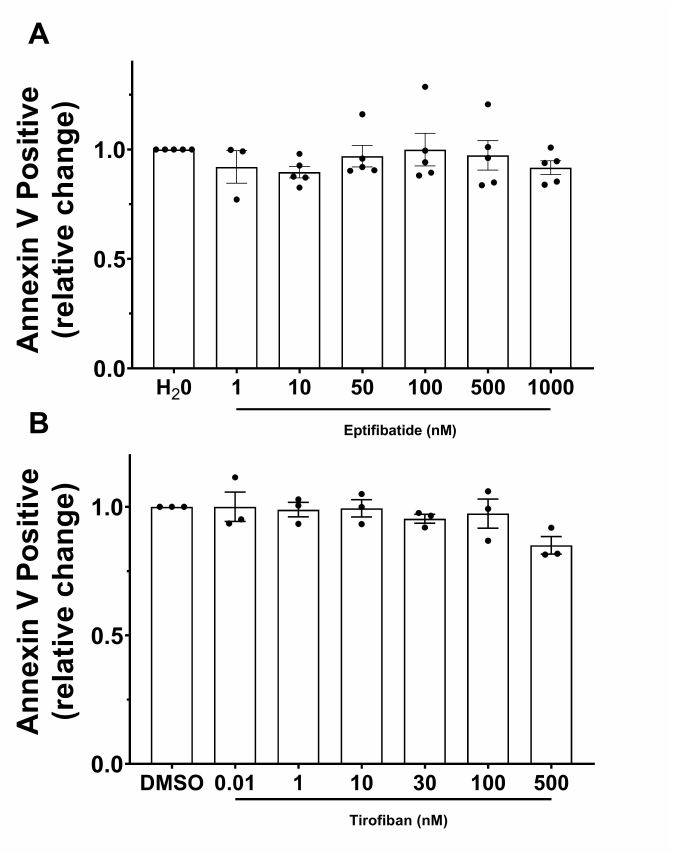
Figure 4. GPIIb / IIIa-antagonists e ff ect on the formation of procoagulant COAT platelets. Platelets were pretreated with increasing doses of ( A ) eptifibatide or ( B ) tirofiban, and activated with convulxin-plus-thrombin. Relative change of the fraction of Annexin-V-positive platelets compared to control condition (vehicle H 2 O or DMSO, respectively) is represented as mean ± SEM from experiments with platelets from di ff erent donors ( n =